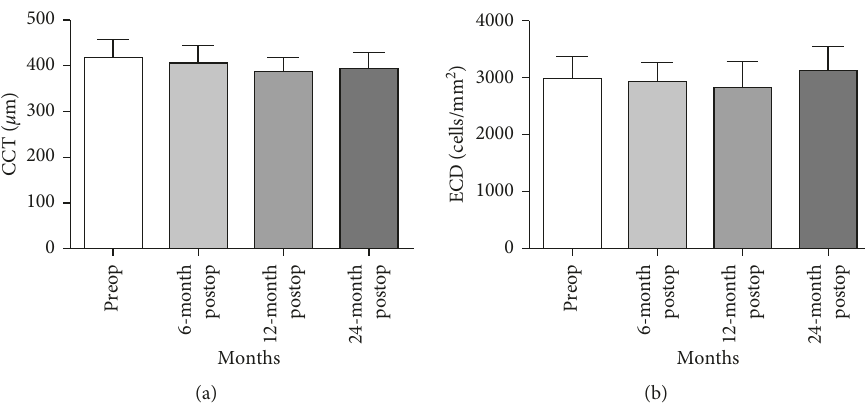
Figure 6: Preoperative and postoperative central corneal thickness and endothelial cell count. (a) Phototherapeutic keratectomy combined with PRK and CXL did not significantly reduce central corneal thickness ( P > 0 . 05) at 6, 12, and 24 months follow-up. (b) Phototherapeutic keratectomy combined with PRK and CXL did not significantly reduce the endothelial cell count at 6, 12, and 24 months follow-up.